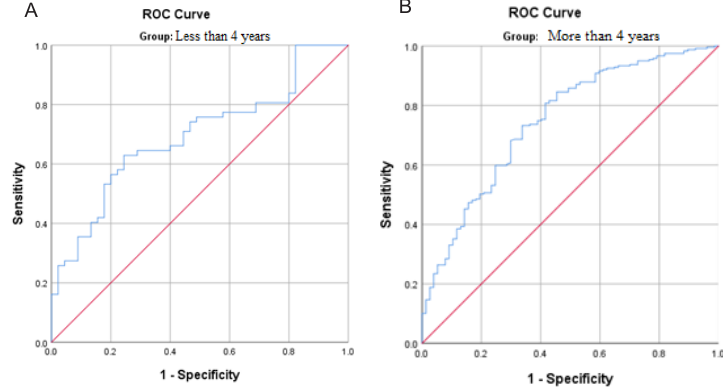
Figure 2. Receiver operating characteristics (ROC) curve diagnostic value of neutrophil to lymphocyte ratio in (A) less than 4 and (B) more than 4 years’ pediatrics suspect to acute